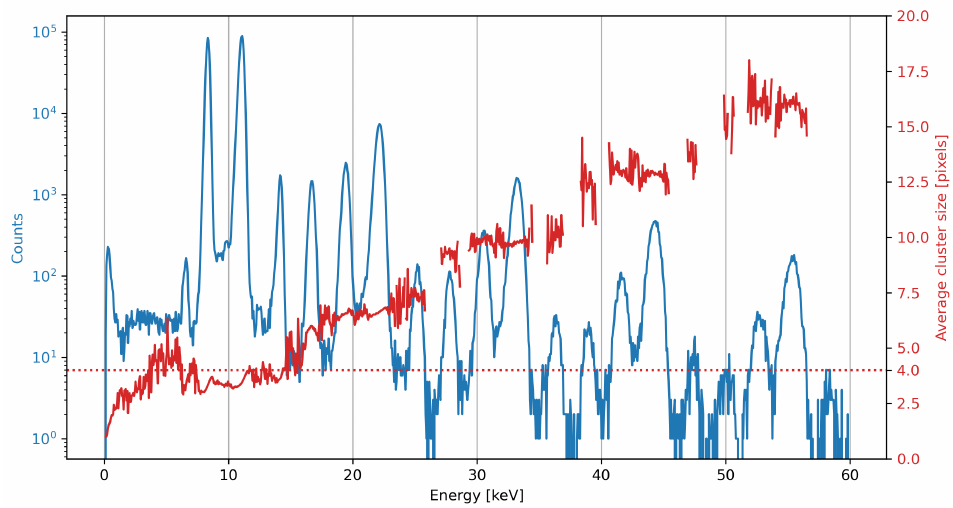
Figure 2. A recorded beamline spectrum showing both photon counts and average charge cluster sizes over a 60keV interval. Beyond the peak at 14keV no significant amount of photons are expected in the beam spectrum. The spectrum shows a pink beam spectrum at the Diamond Light Source I13-1 coherence branch recorded with the SLcam, with a global flux of 4.9 × 10 3 phs − 1 cm − 2 and a global sensor pixel occupancy around 0.1%. The appearance of peaks at pile-up energies is caused in part by small amounts of higher-order beam harmonics, and the fact that this illumination was not spatially homogeneous, with local brightness peaks of pixel occupancies of 3% and higher included in the measured spectrum. The separation of pile-up events from undulator harmonics is